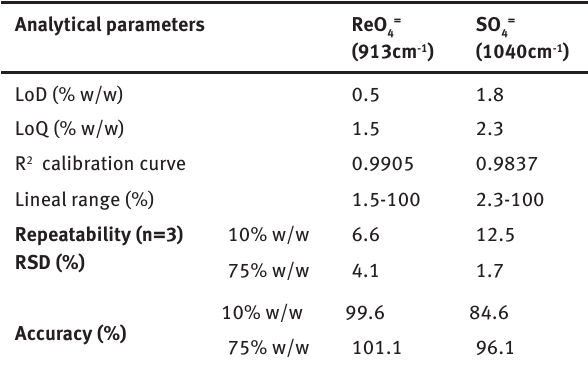
Table 2: Analytical characteristics of the Infrared determination of APR and sulphates in the recycled